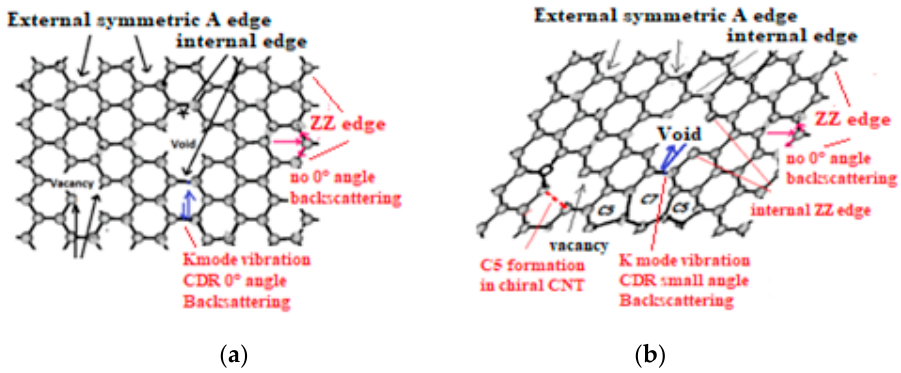
Figure 15. Defect in graphene bulk (vacancies and voids). ( a ) Phonon backscattering on external and internal A edges and ZZ edges in a metallic graphene. No Raman double resonance is possible on the internal edges of vacancies (ZZ edges) in contrast to voids where symmetric A edges exist. ( b ) Formation of C5/C7 odd rings and some internal A edges on vacancies of chiral graphene in consequence of chiral distortion. The reduced A edge asymmetry allows local Raman double resonance (in consequence of Heisenberg incertitude criteria).